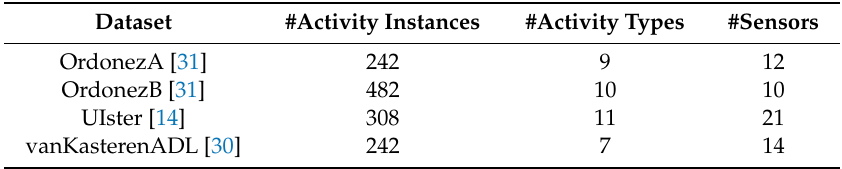
Table 1. Simple description of four datasets.